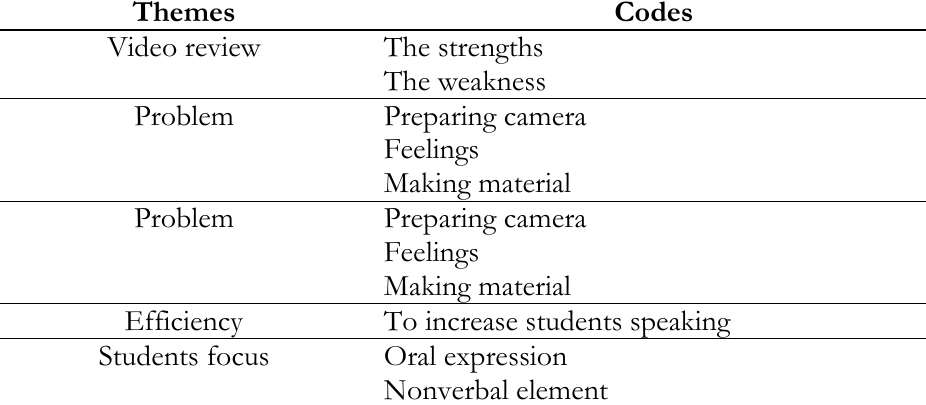
Figure 2. data analysis's process TABLE 2 Themes and